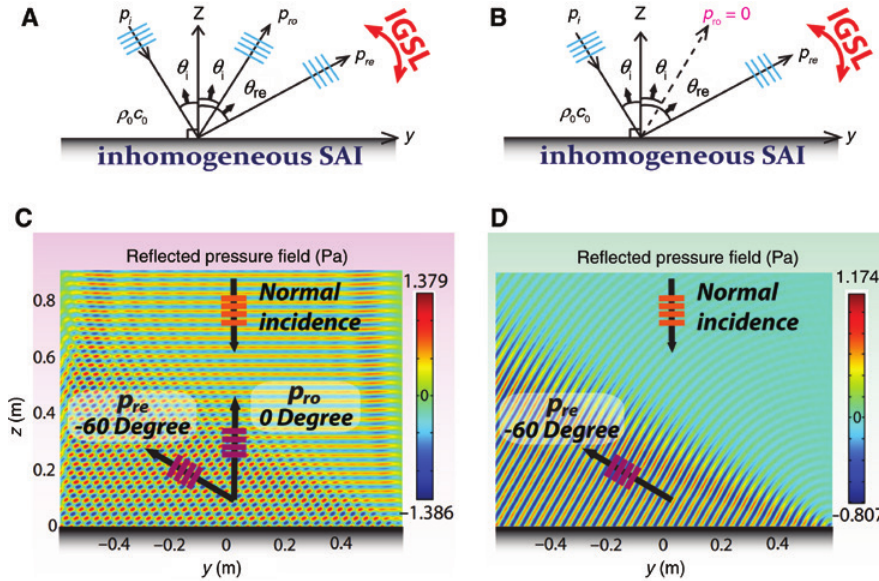
Figure 3: A flat interface with an inhomogeneous specific acoustic impedance for controlling reflection. (A) Schematic of generation of ordinary and extraordinary reflections by a flat interface with an inhomogeneous specific acoustic imped- ance. (B) Suppression of ordinary reflection as the acoustic impedance is properly chosen. (C, D) Numerical results of the reflected pressure fields corresponding to cases (A) and (B) (reprinted from Ref.